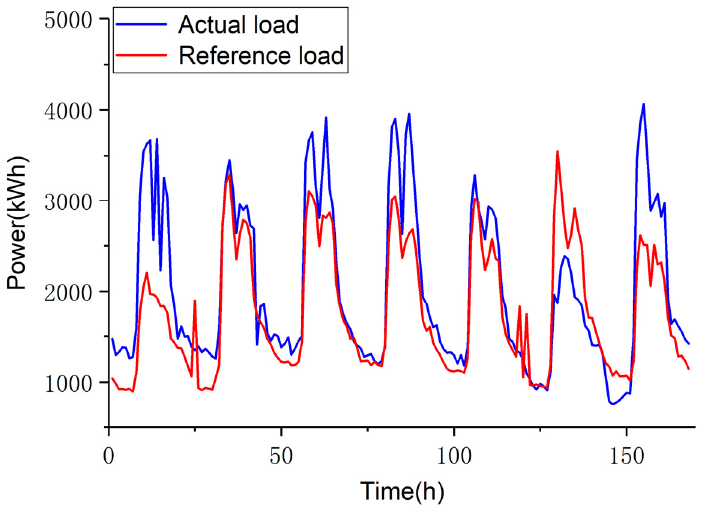
Figure 10. SA-based prediction load power curve and actual load power curve.